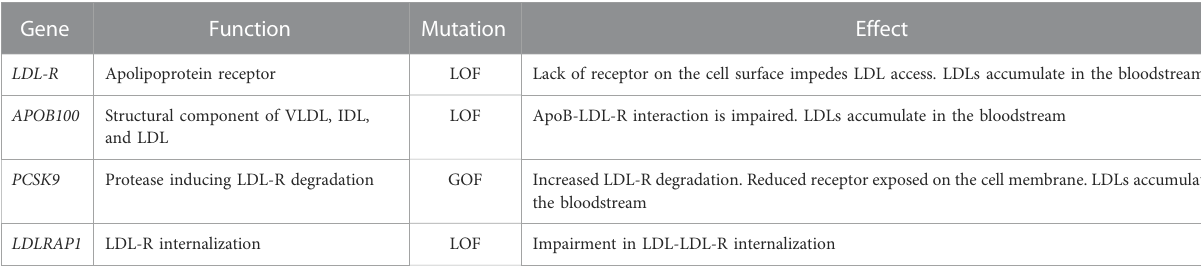
TABLE 1 Genes mutated in FH and descriptions of their physiological roles. Gene Function